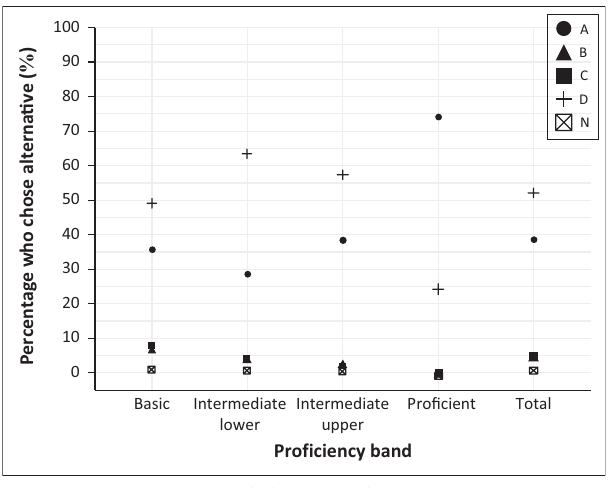
FIGURE 13: For a question requiring calculating a percentage of a percentage, the proportions of students who chose each alternative answer, for the total cohort and for each proficiency